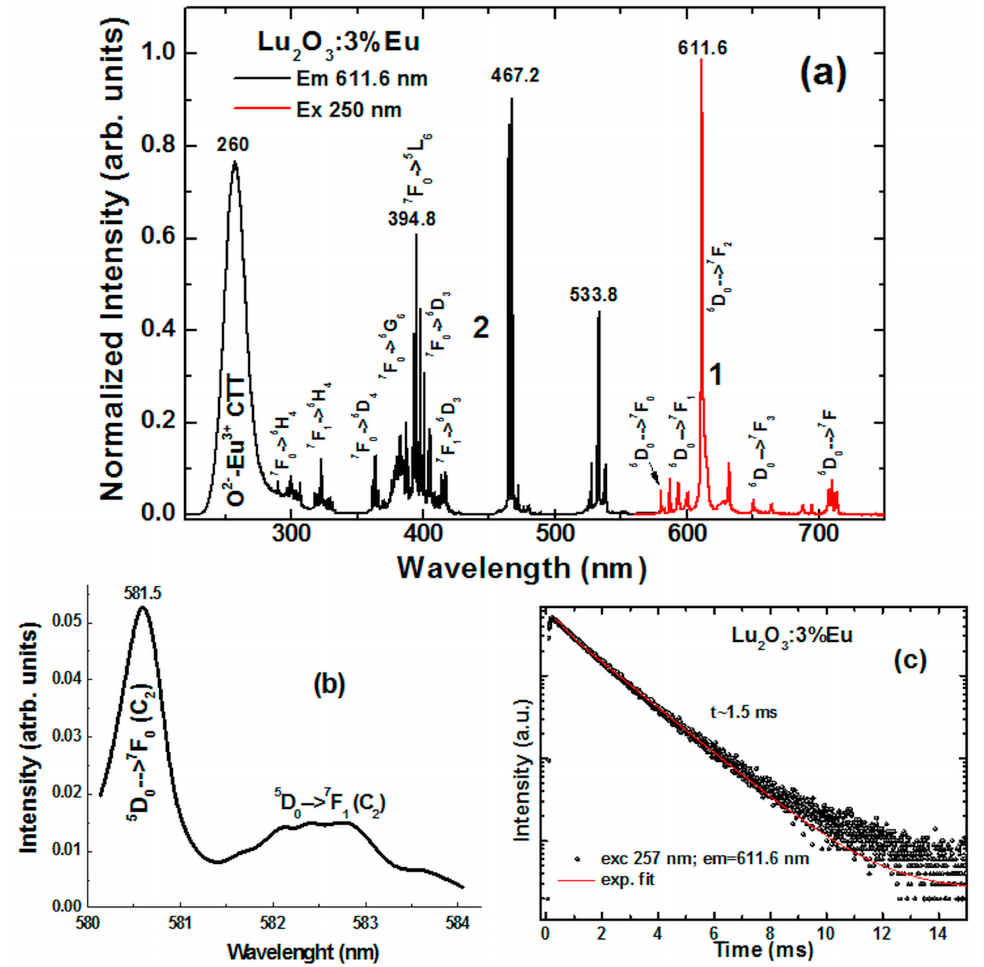
Figure 5. RT photoluminescence (PL) emission (1a, b) and excitation (2a) spectra ( a ) of Eu 3+ luminescence as well as PL decay kinetic ( c ) of Lu 2 O 3 :Eu NP. ( b ) More detailed fragment of the excitation spectrum of Eu 3+ luminescence in the 580–584 nm range related to the 5 D 0 → 7 F 0,1 transitions.